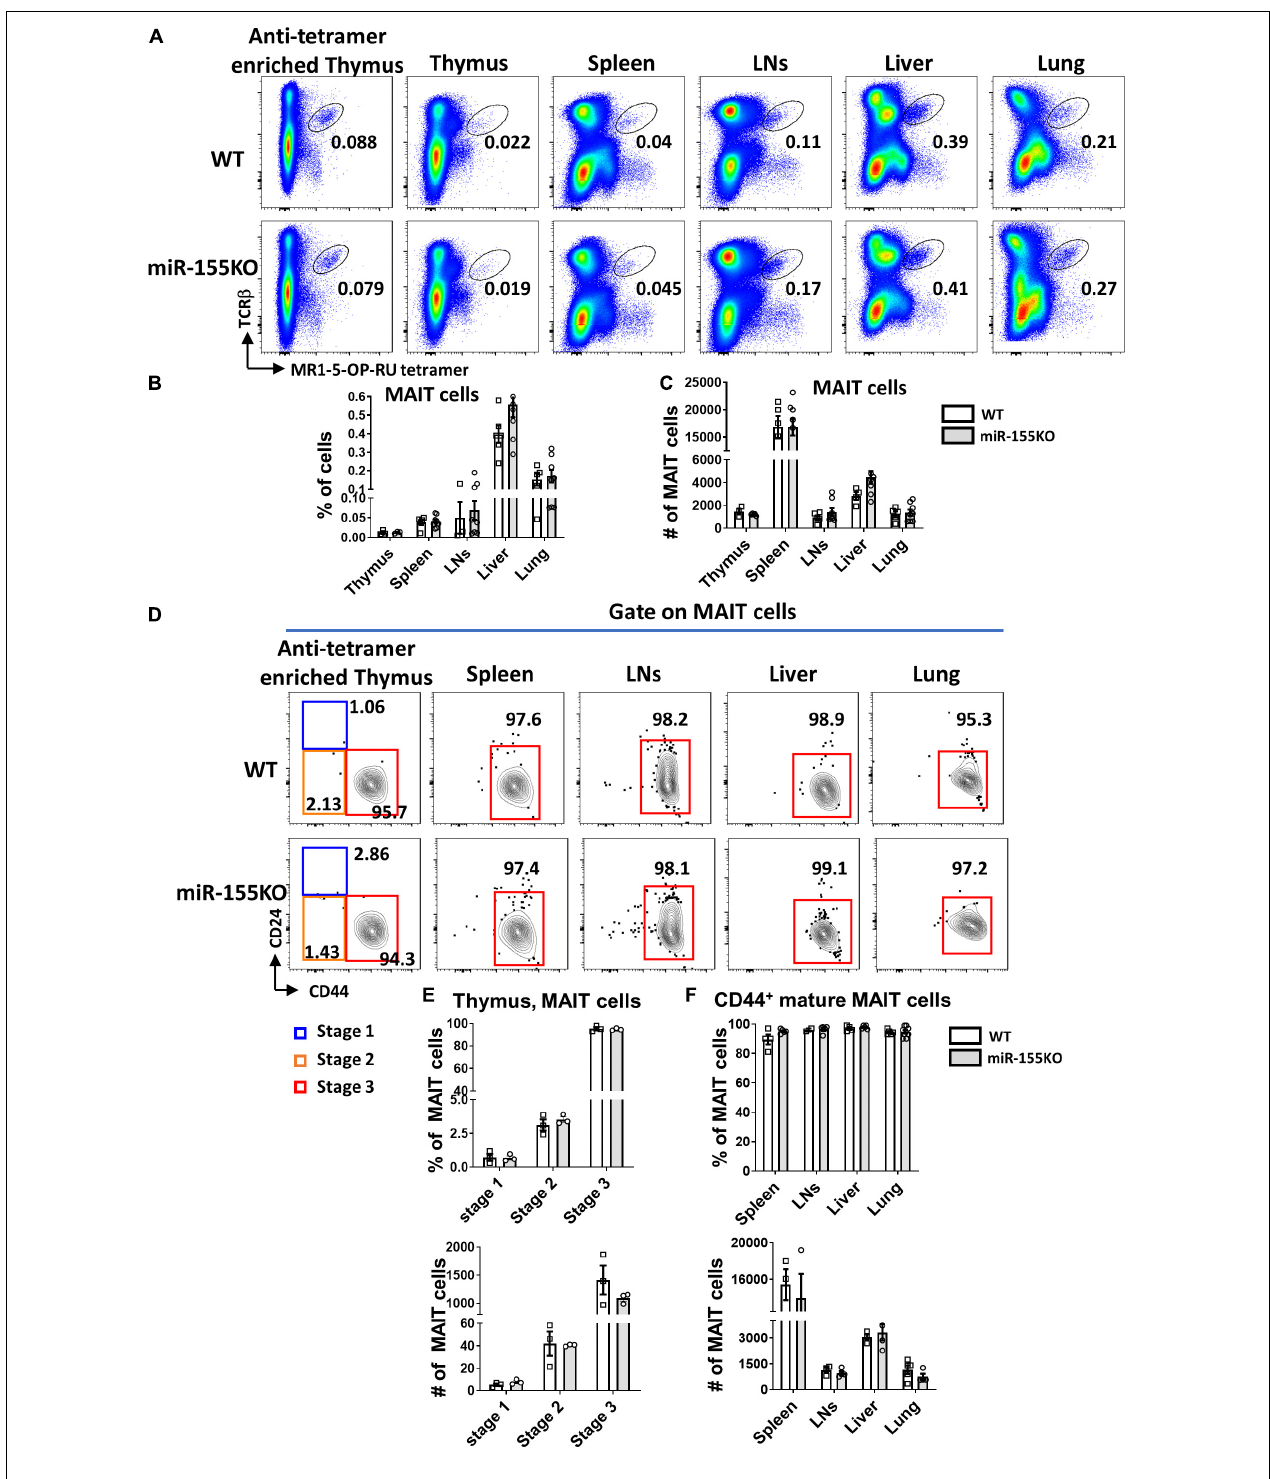
FIGURE 6 | miR-155 deletion results in unchanged MAIT cell development. (A) Flow cytometric plots showing the frequencies of MAIT cells in the thymus, spleen, LNs, liver, and lung of WT and miR-155 KO mice. Numbers indicate percentage of cells within the drawn gate. Graph shows (B) the percentage and (C) absolute numbers of MAIT cells in the indicated organs of miR-155 KO mice. (D) Flow cytometry plot indicating CD24 and CD44 expression gated on MAIT cells from thymus and peripheral organs. (E) Percentage and absolute number of stage 1, stage 2 and stage 3 MAIT cells in enriched thymus. (F) Frequency and absolute number of CD44 + mature MAIT cells in peripheral lymphocytes. Data are from at least three independent experiments. Each mouse is represented as one dot. 3 mice for each group. Data were analyzed by unpaired t -test.